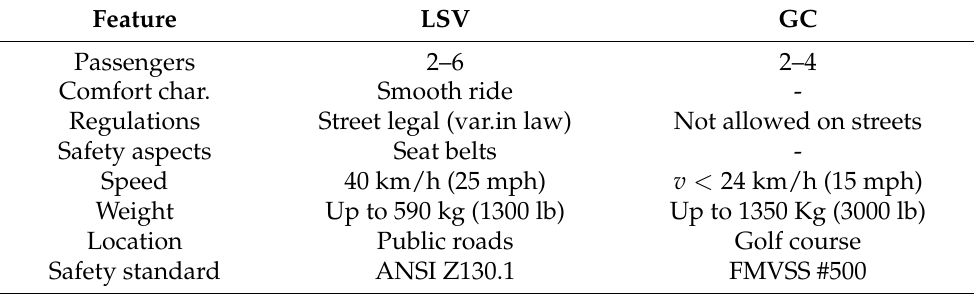
Table 1. Main differences between GCs and LSCs.